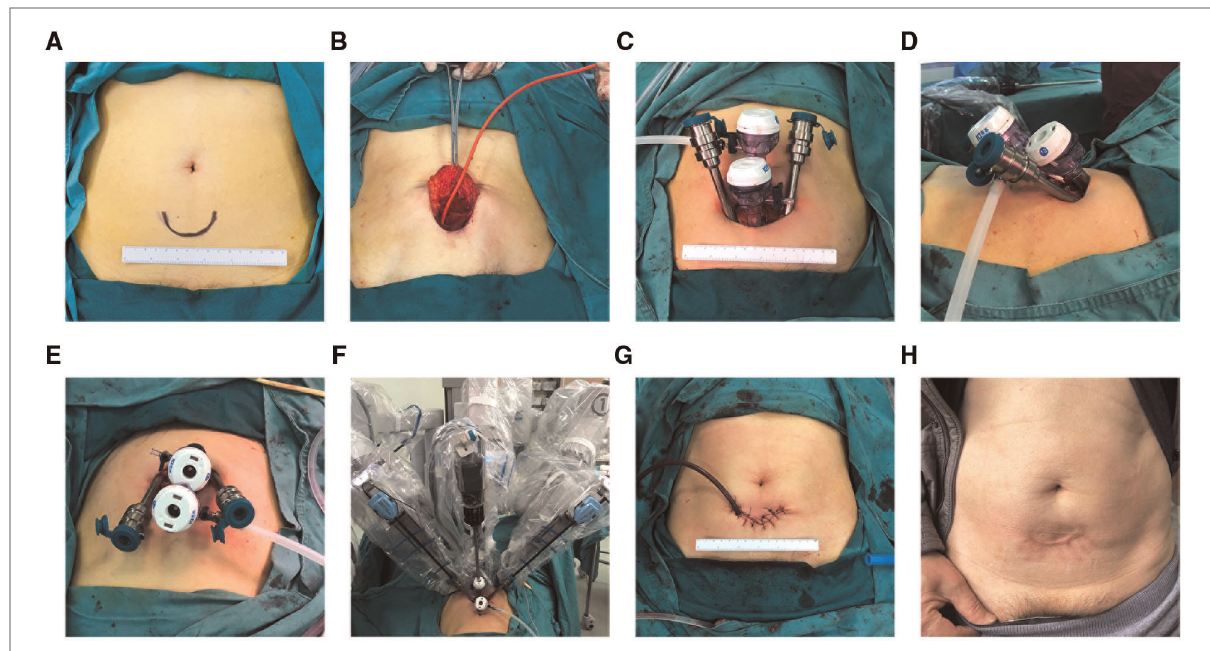
FIGURE 2 Operative view of skin incision, extraperitoneal space creation, and trocar placement and docking: ( A ) Marker of skin incision; ( B ) Balloon insuf fl ation of the extraperitoneal space; ( C ) Four-port con fi guration with a caudocephalad view; ( D ) Four-port con fi guration with a lateral view; ( E ) Four-port con fi guration with a cephalocaudal view; ( F ) Docking con fi guration; ( G ) Wound closure and a drainage placement; ( H ) Appearance of abdominal incision 1 year after the